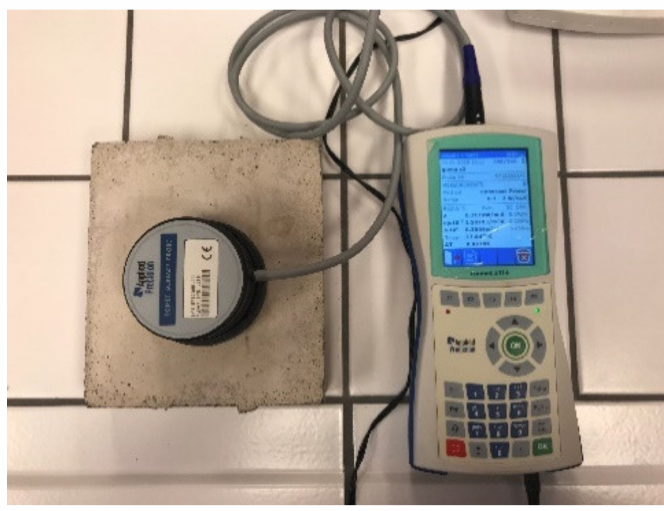
Figure 1. Setup used for the measurement of the thermal